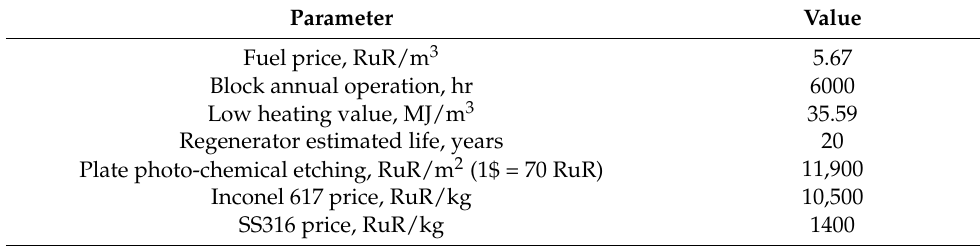
Table 4. Constant values assumed for the regenerator price calculation.